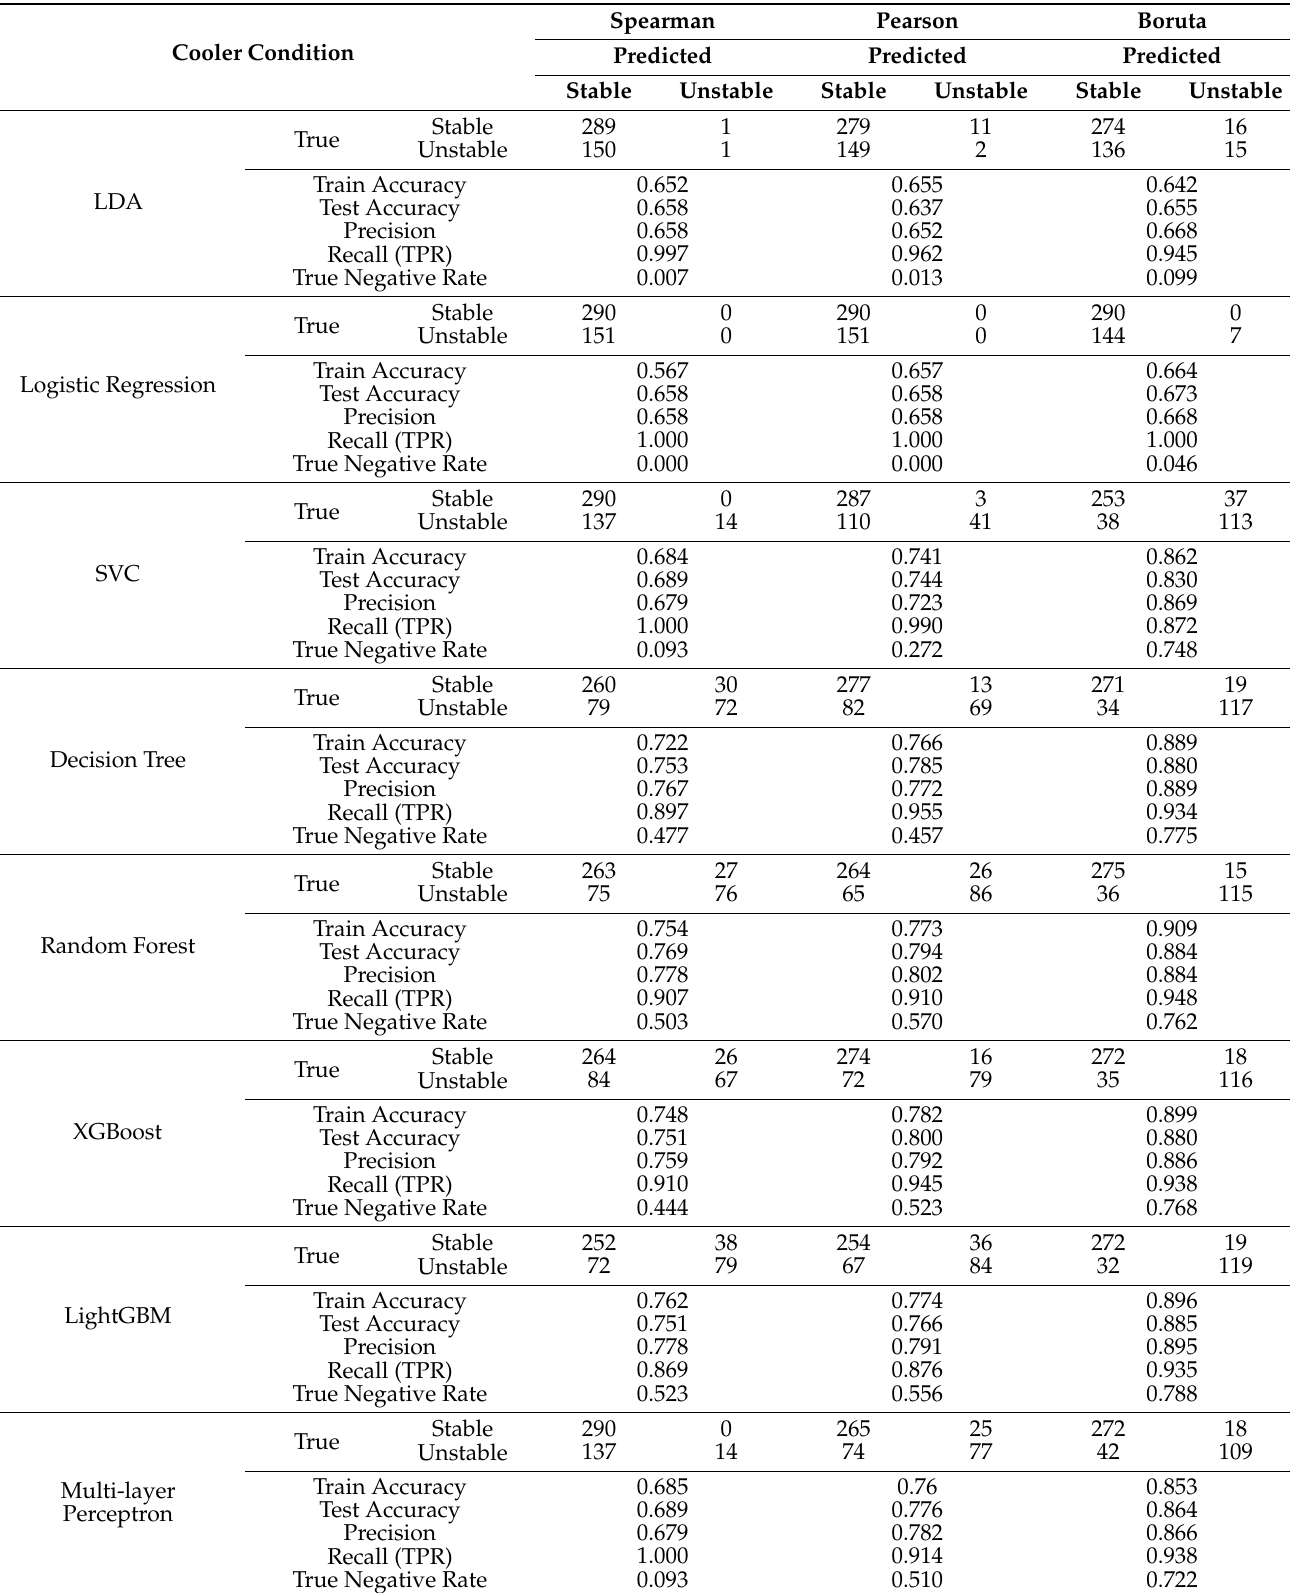
Table 6. Classification evaluation metrics for cooler